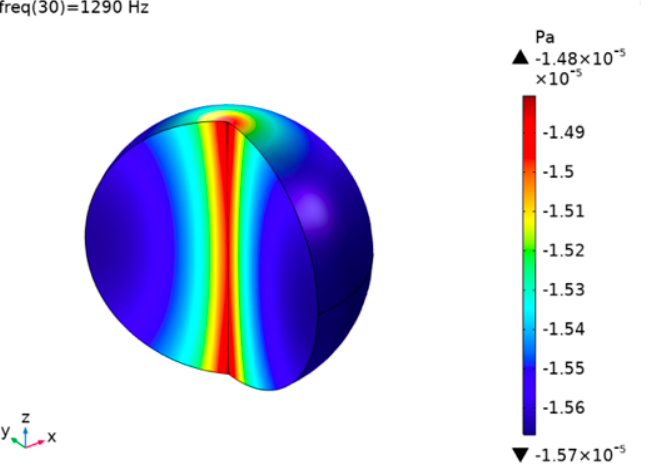
Figure 6. Acoustic pressure distribution of the SPAC at a frequency of 1290 Hz.